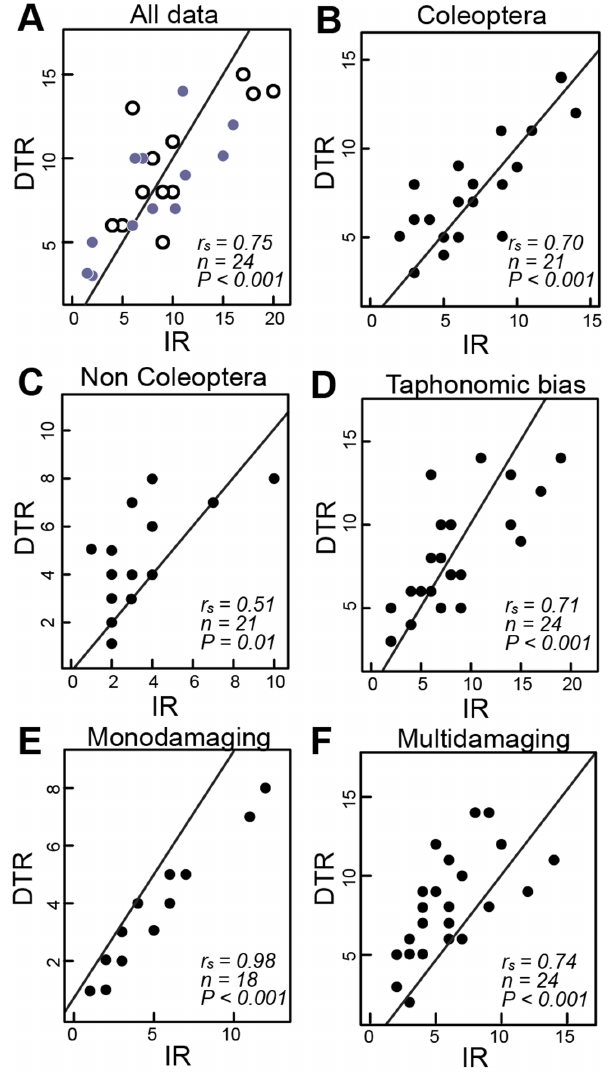
Figure 2. Correlations of insect and induced leaf-damage richness in two Panamanian forests. Spearman’s correlations (r s ) of the number of insect species (Insect richness – IR) vs. number of leaf- chewing damage types (damage type richness – DTR) observed across 24 tropical host plant species, plotted against 1:1 lines, include: ( A ) Total numbers of collected leaf-chewing insect species per host plant at A´rea Protegida de San Lorenzo (Gray, solid circles) and Parque Natural Metropolitano (black, hollow circles). ( B ) IR-DTR correlation for coleopteran species. ( C ) IR-DTR correlation for non-coleopteran species. ( D ) IR-DTR correlation after filtering out leaf damage that is unlikely to be preserved in fossil assemblages. ( E – F ). Separate IR-DTR correlations for insect species that induced one (monodamaging, E) or multiple (multidamaging, F) DTs when feeding. For ( A – F ), each data point is one host-plant species at one site; all data plot with a shallower slope than 1:1, as expected from convergence.